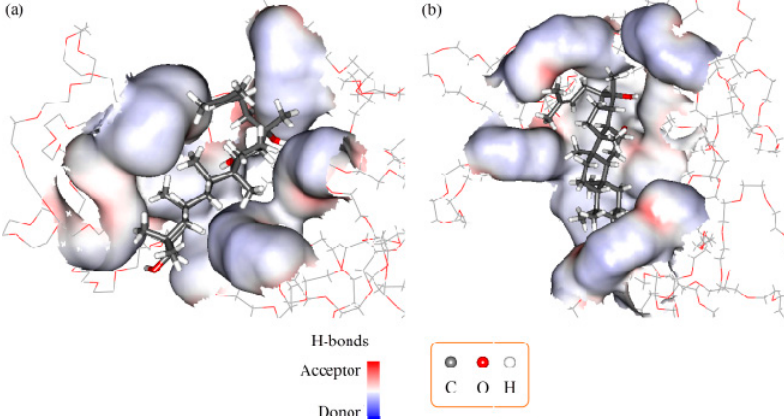
Figure 6. 3D interaction conformations of PPD-F68 in F1 ( a ) and PPD-PEG6000 in F2 ( b ).